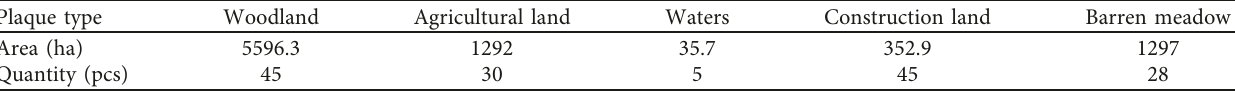
Table 6: X410 plaque type base data.